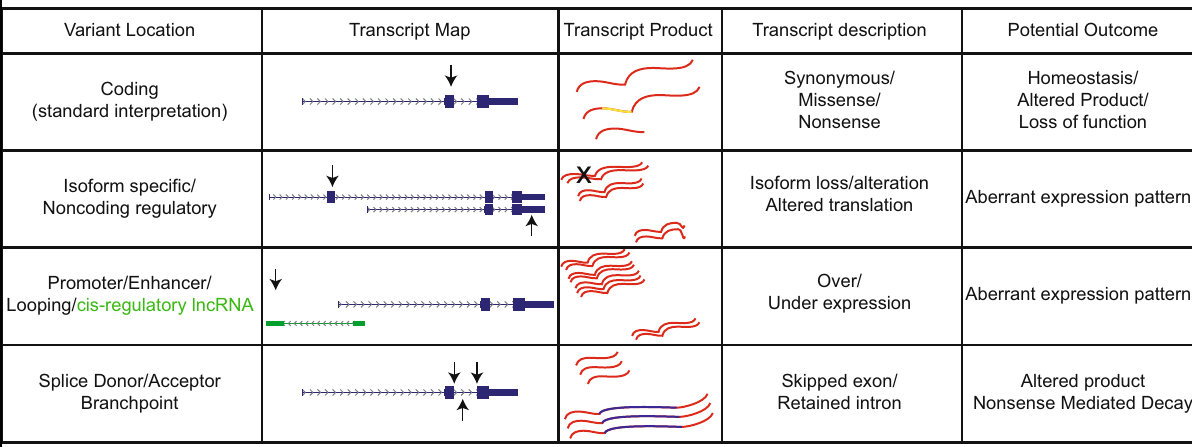
Fig. 2 How coding and noncoding variation can impact gene function. Variants (arrows) at a hypothetical locus are shown along with potential functional